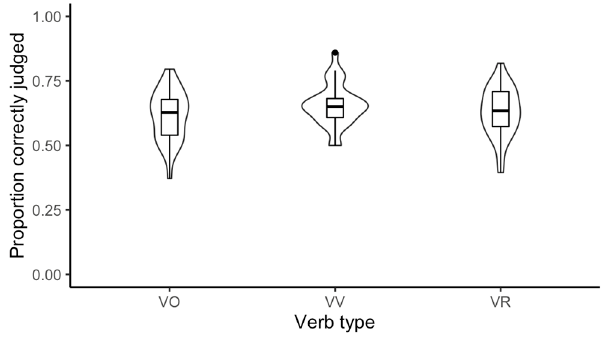
Figure 3. Grammaticality judgement accuracy across the three types of verbs.